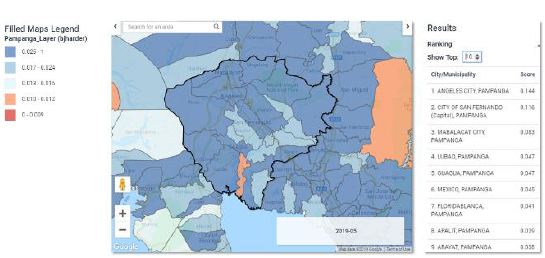
Figure 14. Shows the result of the custom Grade analysis of Pampanga.